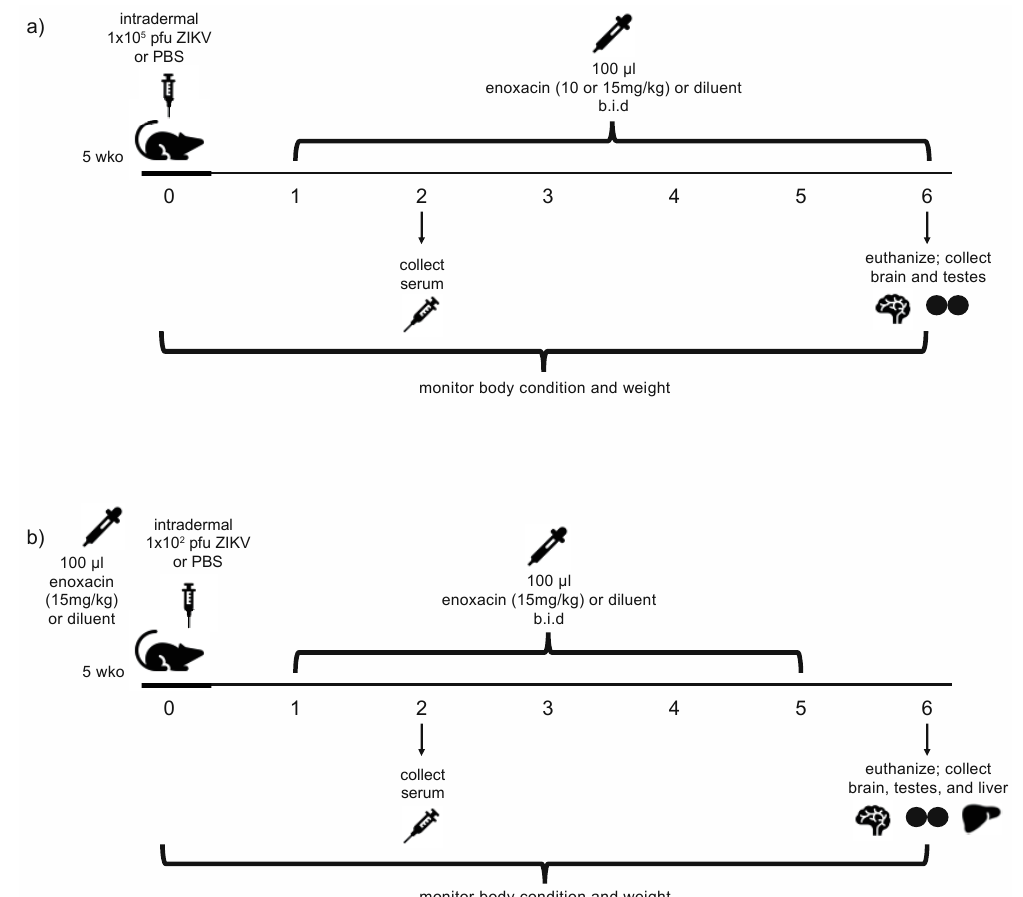
Figure 1. Experimental design. ( a ) In experiment 1, five-week-old A129 mice were injected with Zika virus (ZIKV) (1 × 10 5 pfu) or phosphate buffered saline (PBS) then treated orally with enoxacin (10 or